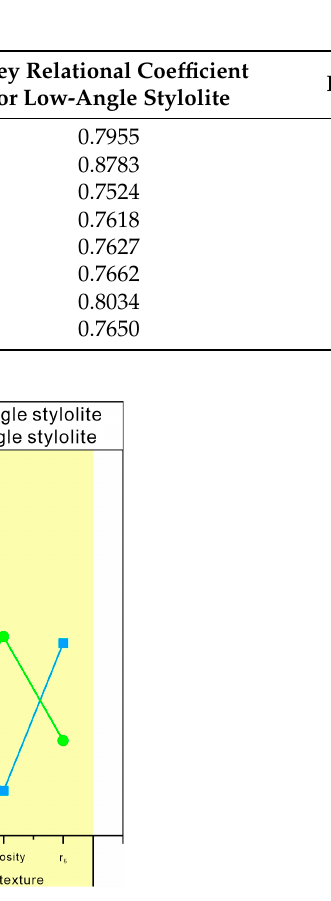
Figure 13. Analyzing the results of grey correlation analysis.